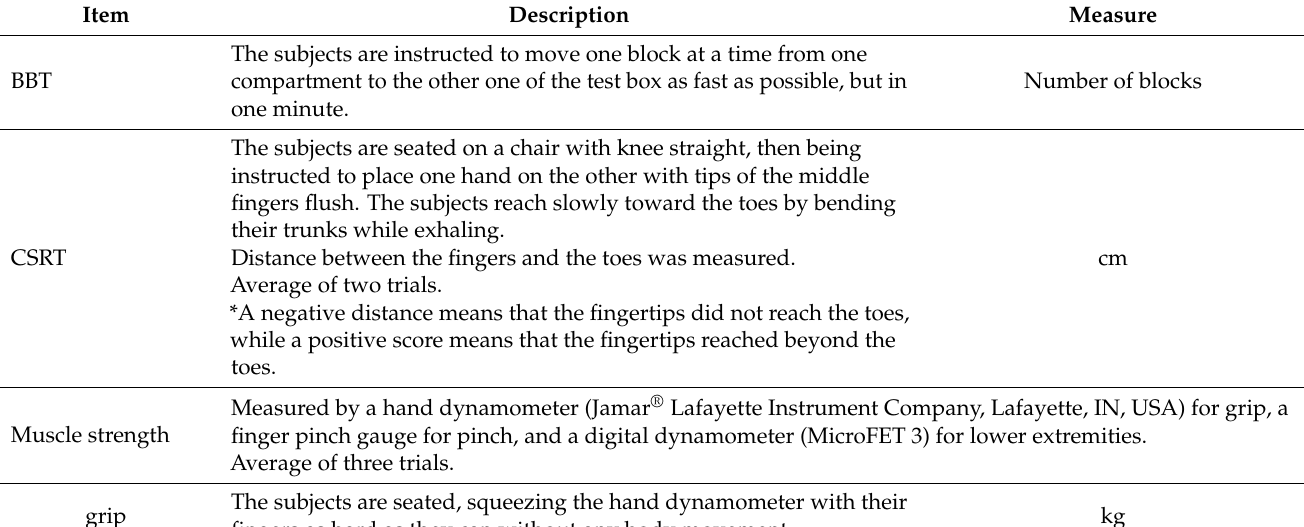
Table 2. Brief description of physical functional performance